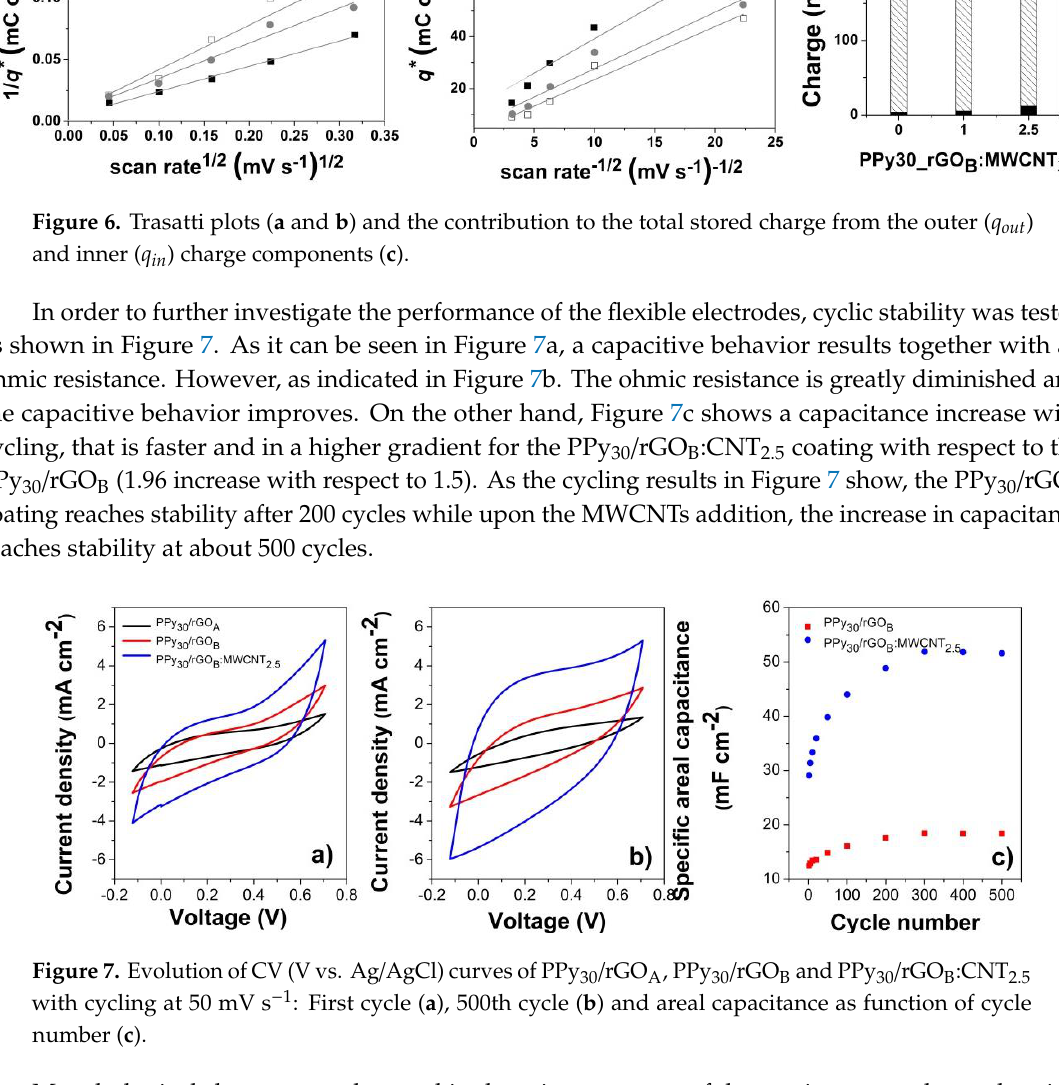
Figure 6. Trasatti plots ( a and b ) and the contribution to the total stored charge from the outer ( q out ) and inner ( q in ) charge components ( c ).